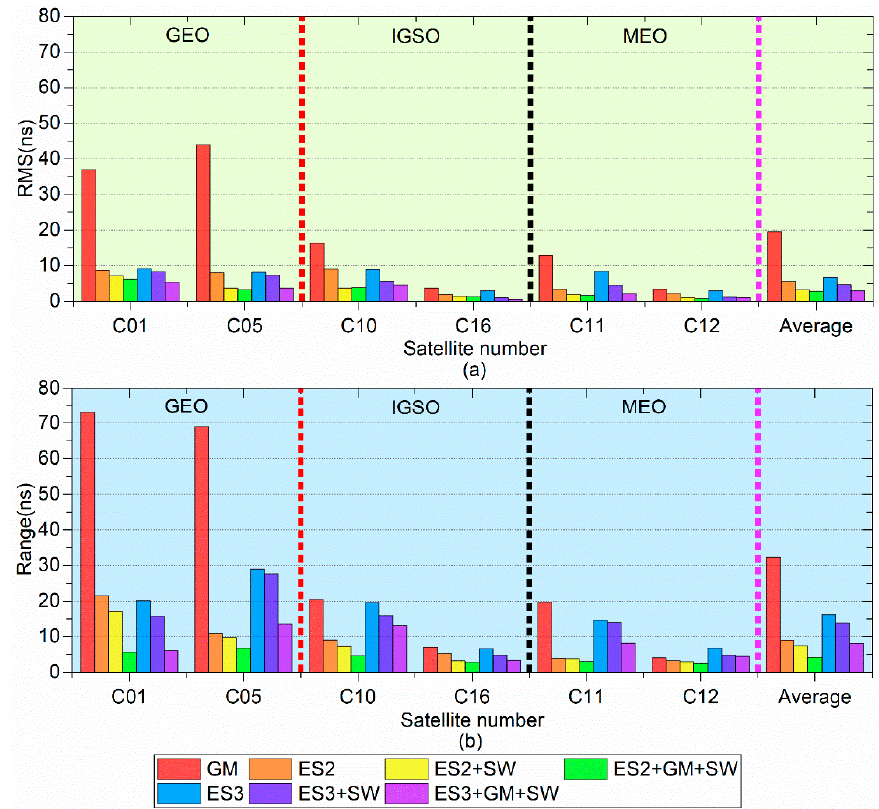
Figure 11. Variation diagram of 24 h forecast accuracy (RMS) and stability (Range) using different models: ( a ) is the changes of RMS, and ( b ) is the changes of Range. Appl. Sci. 2020 , 9 , x FOR PEER REVIEW